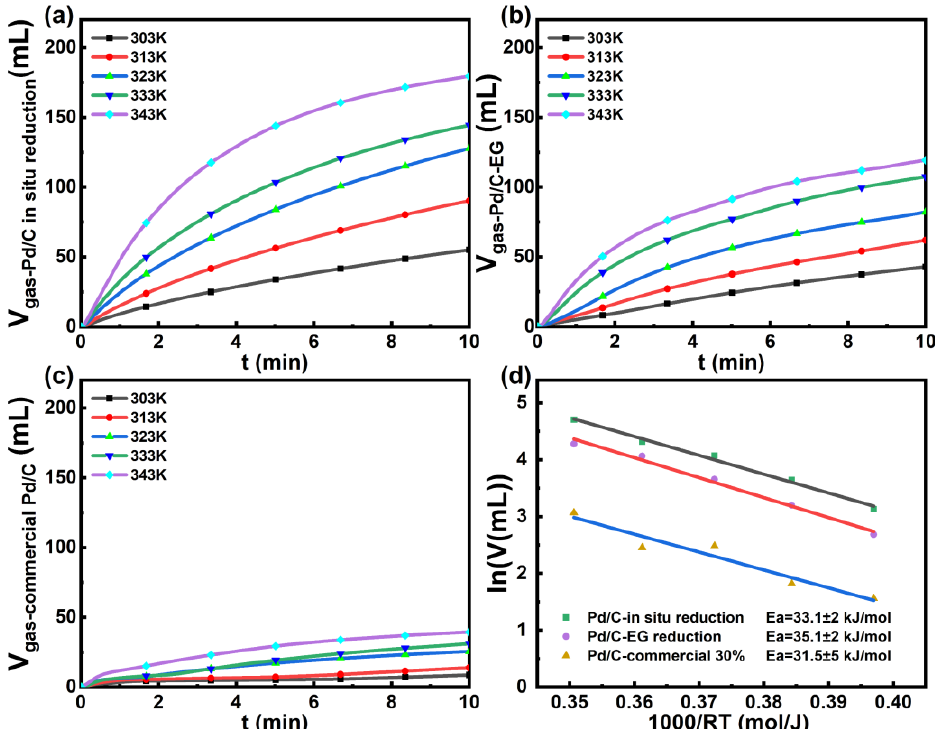
Figure 3. Time course of reforming gas evolution in 1.1 M formic acid + 0.8 M sodium formate over ( a ) Pd/C in situ reduction, ( b ) Pd/C-EG reduction, and ( c ) Pd/C-30% commercial; ( d ) analysis of the activation energy of these catalysts.